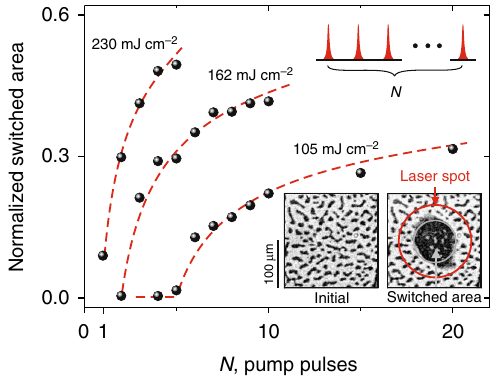
Fig. 3 Photo-magnetic switching with multiple pulses at different pump fl uences. A single pulse with the fl uence of 230 mJ cm − 2 is able to create a stable domain. The time period between the pulses is 1 ms (repetition rate was 1 kHz). The central photon energy of the pump is 1.1 eV ( λ = 1140 nm) and the pump polarization is along [110]. The normalized switched area was calculated as the ratio of the recorded domain area (the black large domain) to the area of pump laser spot π r 2 (limited by red circle). Dashed lines are guides to the eye. The inset shows the magnetic domain patterns